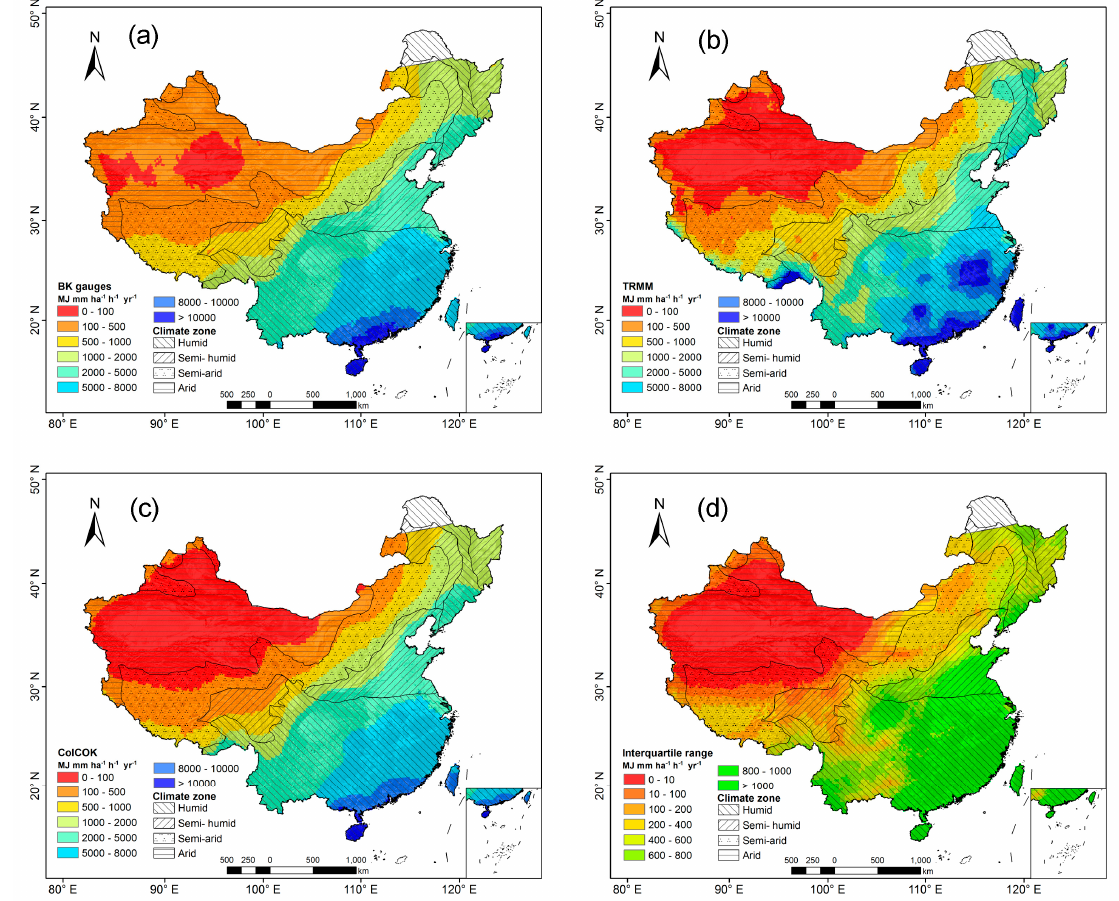
Figure 4. Spatial distribution maps of annual rainfall erosivity based on: ( a ) BK gauges, ( b ) TRMM, ( c ) ColCOK, and ( d ) interquartile range (IQR) of rainfall erosivity based on ColCOK at 0.25° × 0.25° for the 2002 to 2013 period, across China.